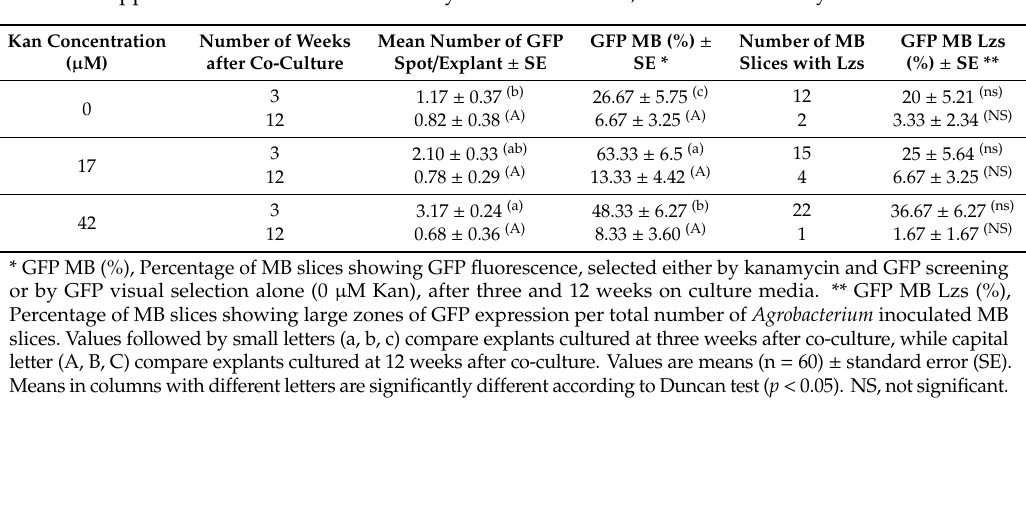
Figure 1. Hansen 536 regeneration via organogenesis: ( a ) adventitious shoot regeneration after 30 days of culture on WPMm5 medium. ( b ) MB slices (1 cm 2 , 2 mm thick) used as starting explant for the transformation experiment (bar = 1 cm). Table 3. GFP expression efficiency of Hansen 536 MB slices after three and 12 weeks of culture on WPMm5 medium supplemented with different kanamycin concentrations, or without kanamycin selection.